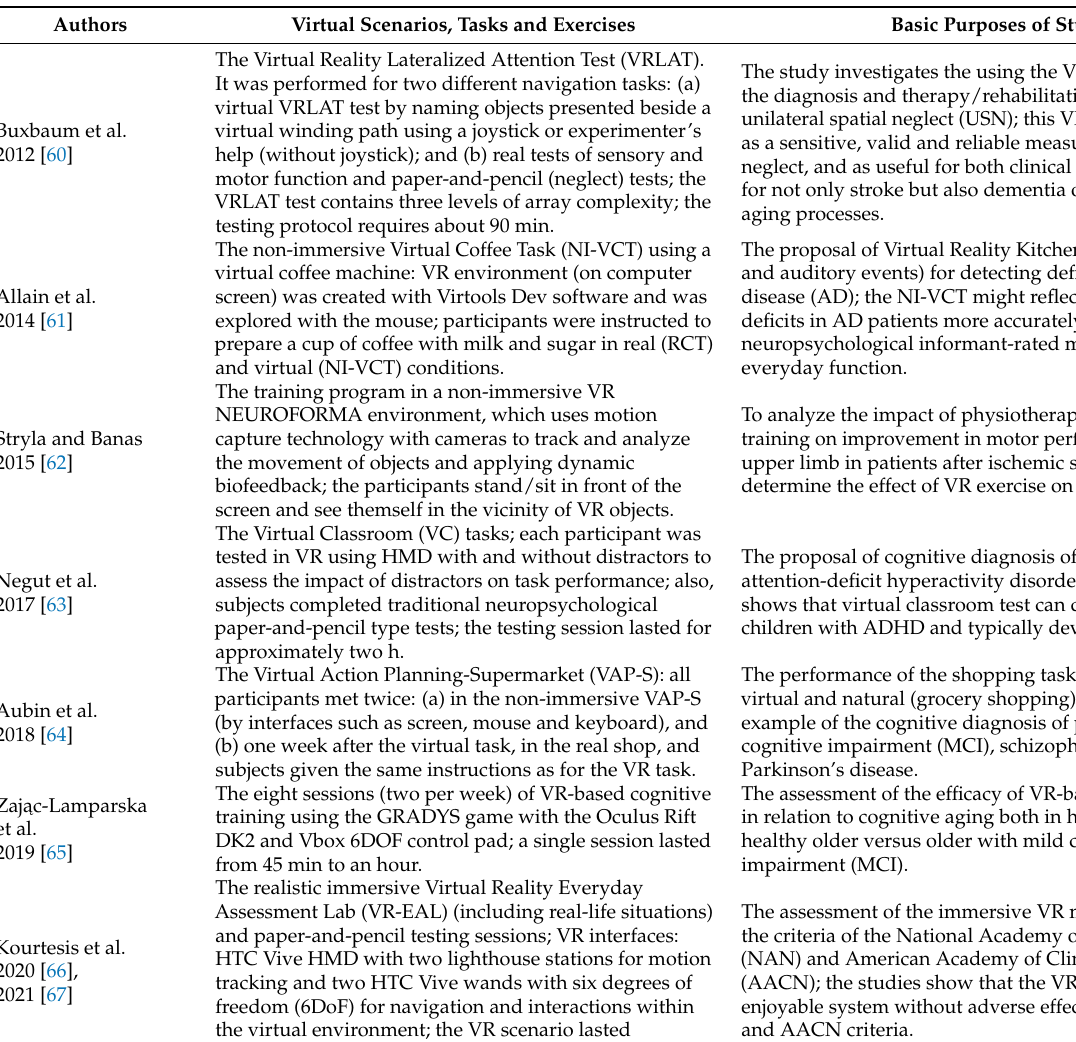
Table 1. The examples of multidisciplinary research examining the effects of VR cognitive and motor task/exercise/procedural training in healthy and various patient groups (children, adults, and elderly people). These studies demonstrate the effectiveness of virtual reality methods in assessing brain functions both in health and disease. Moreover, VR tasks can enhance specificity and ecological validity by presenting the patients with functional situations that resemble real daily